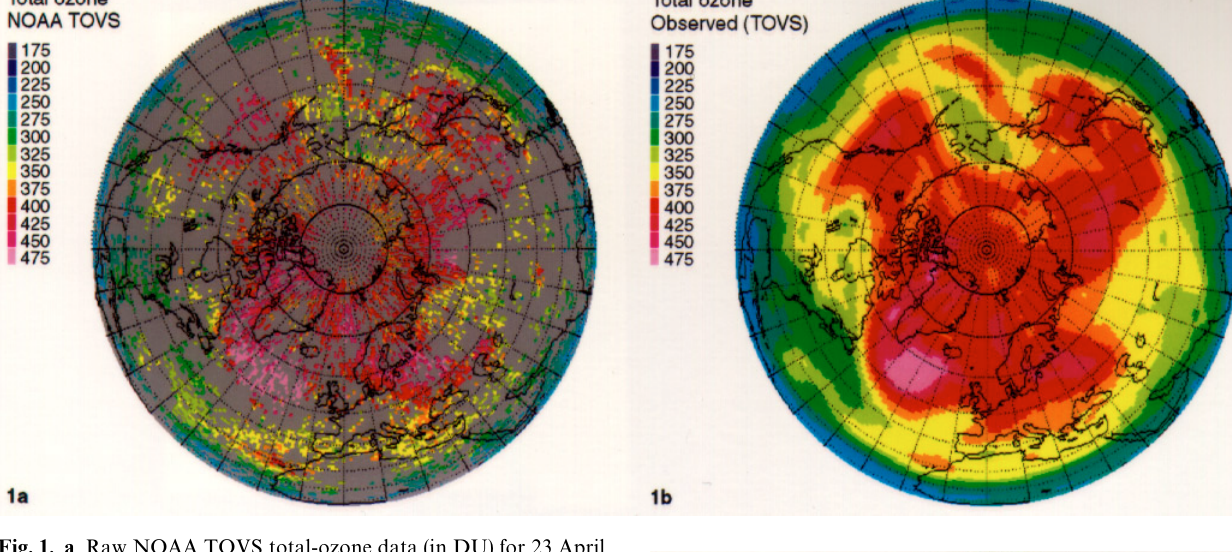
Fig. 1. a Raw NOAA TOVS total-ozone data (in DU) for 23 April 1992; b assimilated NOAA TOVS total-ozone data (in DU) for 23 April 1992 at 1200